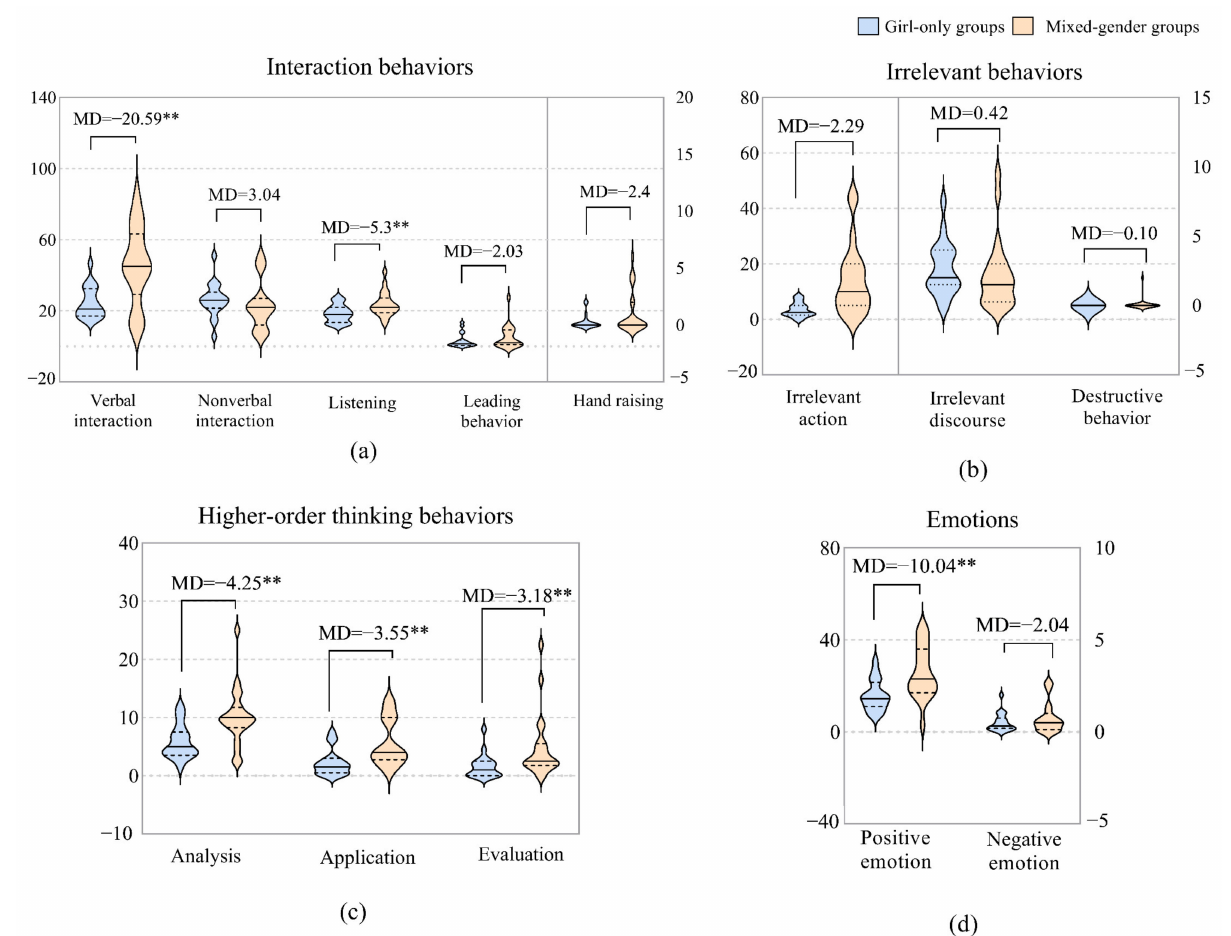
Figure 5. Differences between girls in girl-only groups and mixed-gender groups. ( a ) Interaction behaviors: the frequencies of verbal and nonverbal interactions are reflected on the left Y axis; the frequencies of behaviors of listening, leading, and hand raising are reflected on right Y axis. ( b ) Emotions: the frequency of positive emotion and negative emotion. ( c ) Irrelevant behaviors: the frequency of irrelevant action is reflected on the left Y axis, and the frequencies of irrelevant discourse and destructive behavior are reflected on the right Y axis. ( d ) Higher-order thinking behaviors: the frequencies of analysis, application, and evaluation behaviors. Note: **: p <